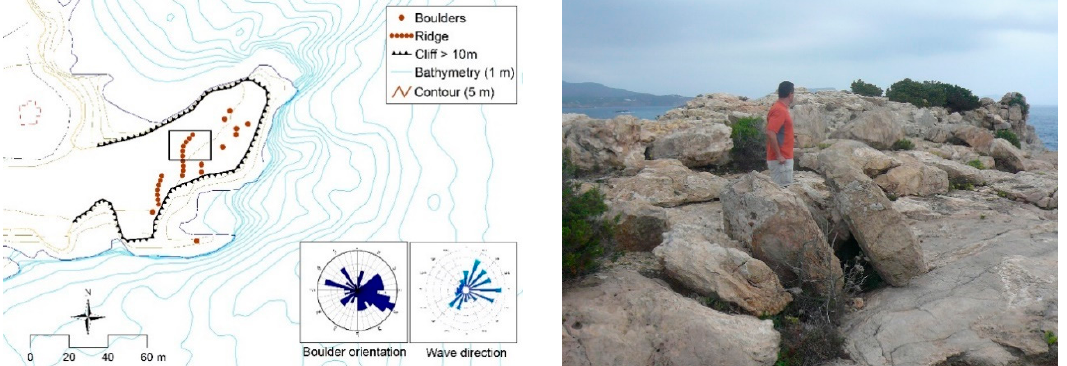
Figure 9. Geomorphological scheme of the Punta Arabí area. Roses show the prevailing waves ( left ) and dominant orientation of boulders ( right ).